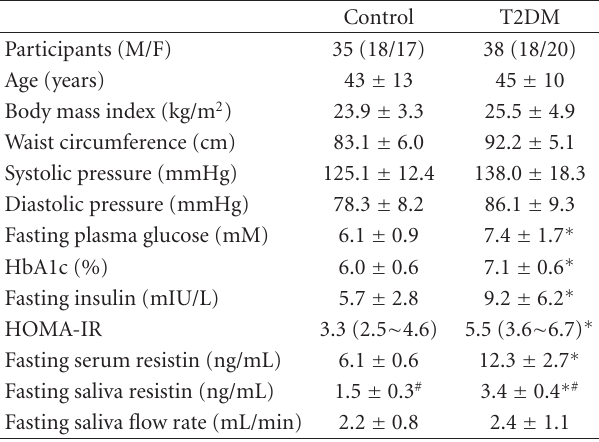
Table 1: The general information and laboratory data of the new diagnosed type 2 diabetic patients and non-diabetes